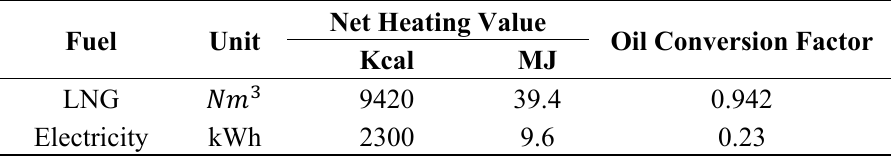
Table 7. Net heating value & oil conversion factor of fuel.